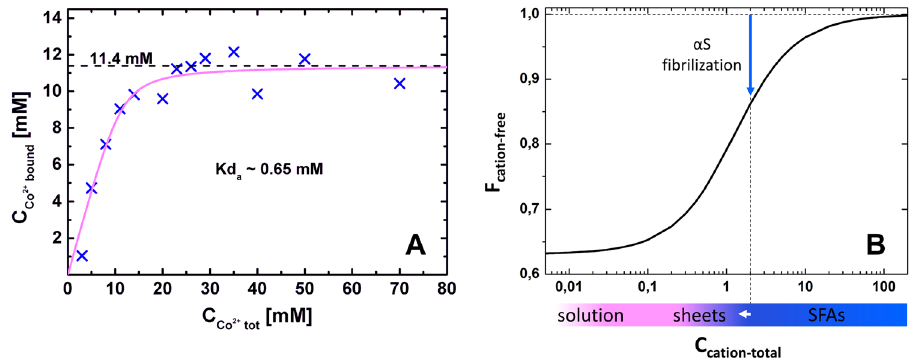
Figure 4. Co 2 + binding by α S. ( A ) Binding of Co 2 + ions by α S. ( B ) Calculated fraction of divalent cations that remain in solution as a function of the total divalent cation concentration at 100 µ M α S assuming K d = 0.65 mM ( A ). At the experimental conditions used here to produce SFAs (2mM CaCl 2 ) a significant fraction of the cations is expected to become associated with fibrils (vertical blue arrow). The higher order organization of fibrils is very sensitive to ionic strength of the solution. The horizontal bar indicates the transition from a solution of fibrils (white) to fibrillar sheets (pink) and SFAs (blue). Since at 2 mM a significant fraction of the cations is depleted from solution during polymerization (and SFA formation) the solution conditions move closer to the sheet-SFA transition point and possibly cross it (horizontal white arrow). In response to that the newly formed outer layers of the SFA adopt a different architecture where the fibril mutual orientation converges towards higher crossing angles.